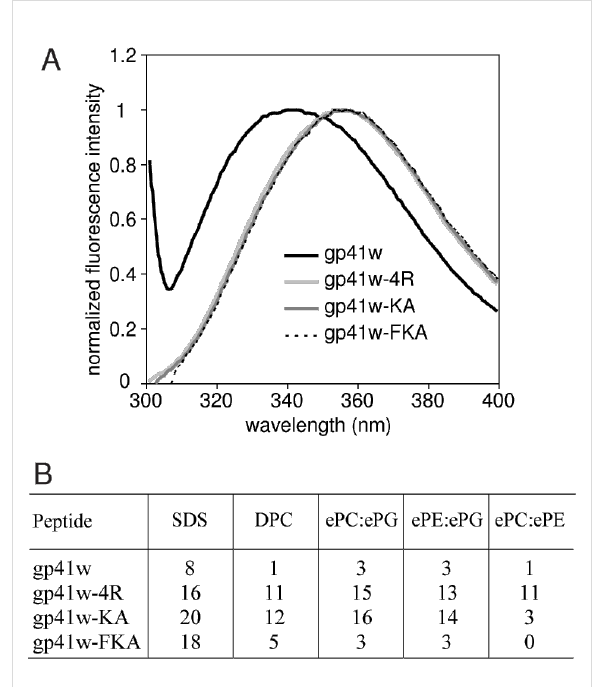
Figure 2: (A) Normalized Trp emission spectra of the gp41w deriva- tives in buffer. The spectra have been normalized to the fluorescence intensity value measured at the wavelength of the emission maximum. (B) Blue shifts (nm) in the Trp maximum-emission wavelength for gp41w, gp41w-4R, gp41w-KA and gp41w-FKA in the presence of micelles and large unilamellar vesicles (LUVs) of varying composition. All wavelengths of the maxima are based on average values from three separate scans. Abbreviations for the detergents and lipids are: SDS, sodium dodecylsulfate; DPC, dodecylphosphocholine; ePC, egg- derived L- α -phosphatidylcholine; ePE, egg-derived L- α -phosphatidyl- ethanolamine; ePG, egg-derived L- α -phosphatidylglycerol; Chol,